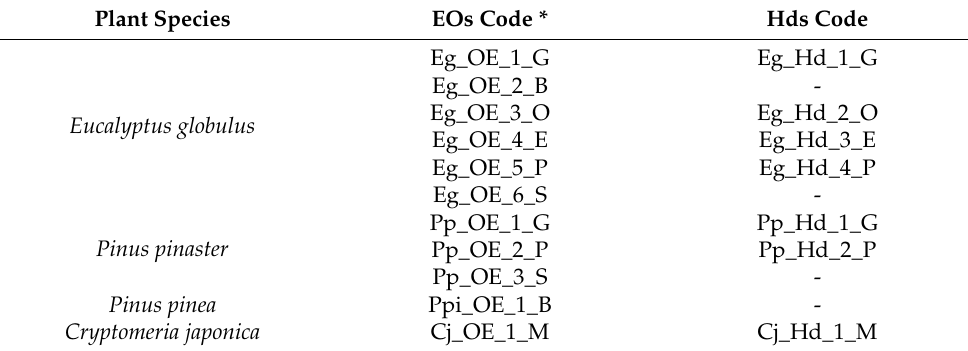
Table 10. Analyzed essential oils (EOs) and hydrolates (Hds) and their codes. Plant Species EOs Code * Hds Code